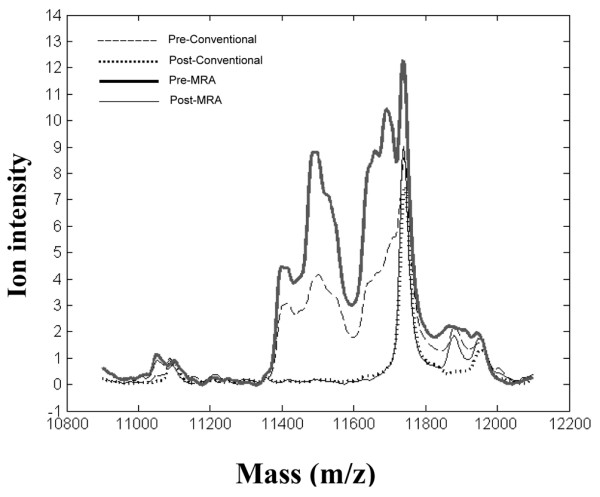
SELDI-TOF MS profiles for patients with SJIA before and after conventional or MRA treatment. Sera taken before conventional and MRA treatment show similar patterns that are distinct from the post-treatment profiles. Mean spectra of all patients are shown in the 11- to 12-kDa m/z range. Means are compiled from 8 samples before and after conventional therapy and 15 samples before and after MRA therapy, each sample run in duplicate. Spectra were preprocessed as described in the Materials and methods section. MRA, humanized anti-IL-6 receptor monoclonal antibody; SELDI-TOF MS, surface-enhanced laser desorption/ionization time-of-flight mass spectrometry SJIA, systemic juvenile idiopathic arthritis.